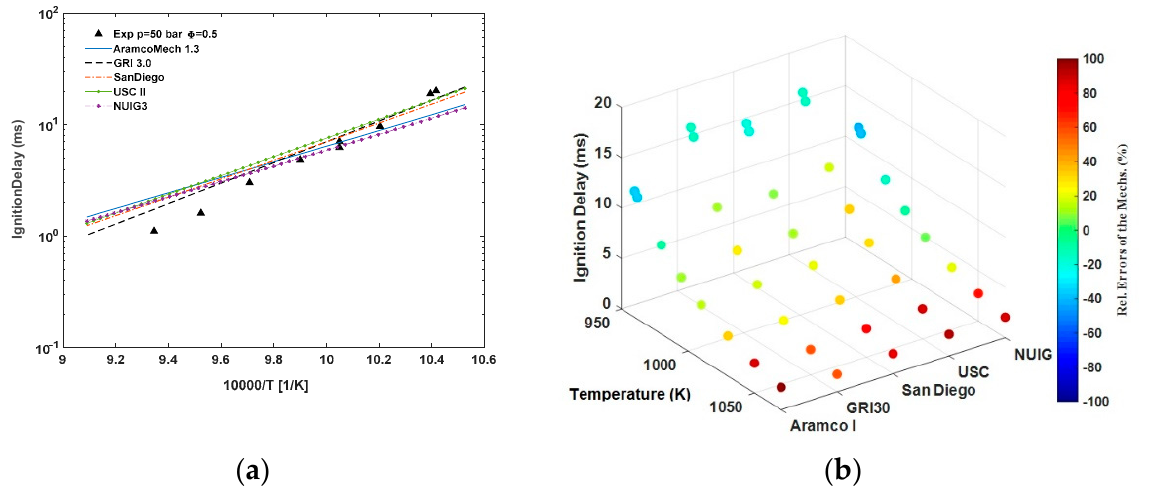
Figure 6. ( a ) Comparison of ignition delay time with the experimental data for 50%CH 4 /30%H 2 /20%CO for different mechanisms [40]; ( b ) The relative error of simulation from experiments.